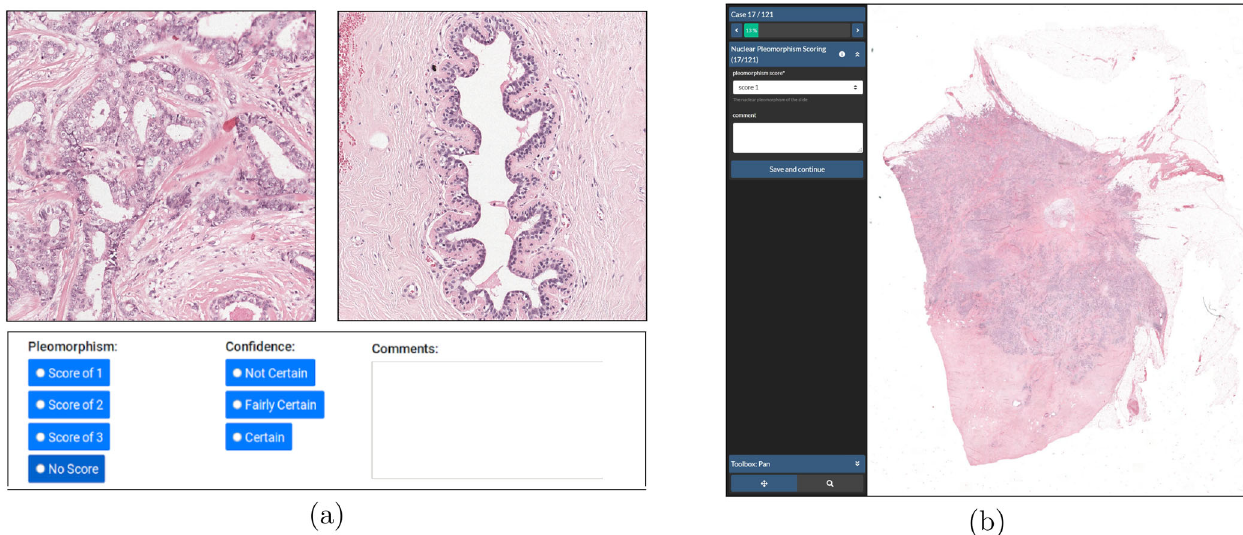
Fig. 9 Web platforms for the ROI- and slide-study. An example query from the web platform of the ROI-study ( a ) included a pair of tumor and normal ROIs from the same patient. Ten pathologists were invited to score nuclear pleomorphism and to provide con fi dence scores for such 125 queries from 39 whole-slide images. An example from the slide-study ( b ) included a whole-slide image, which could be viewed in multiple magni fi cations. Four pathologists were invited to score nuclear pleomorphism on 121 whole-slide images.